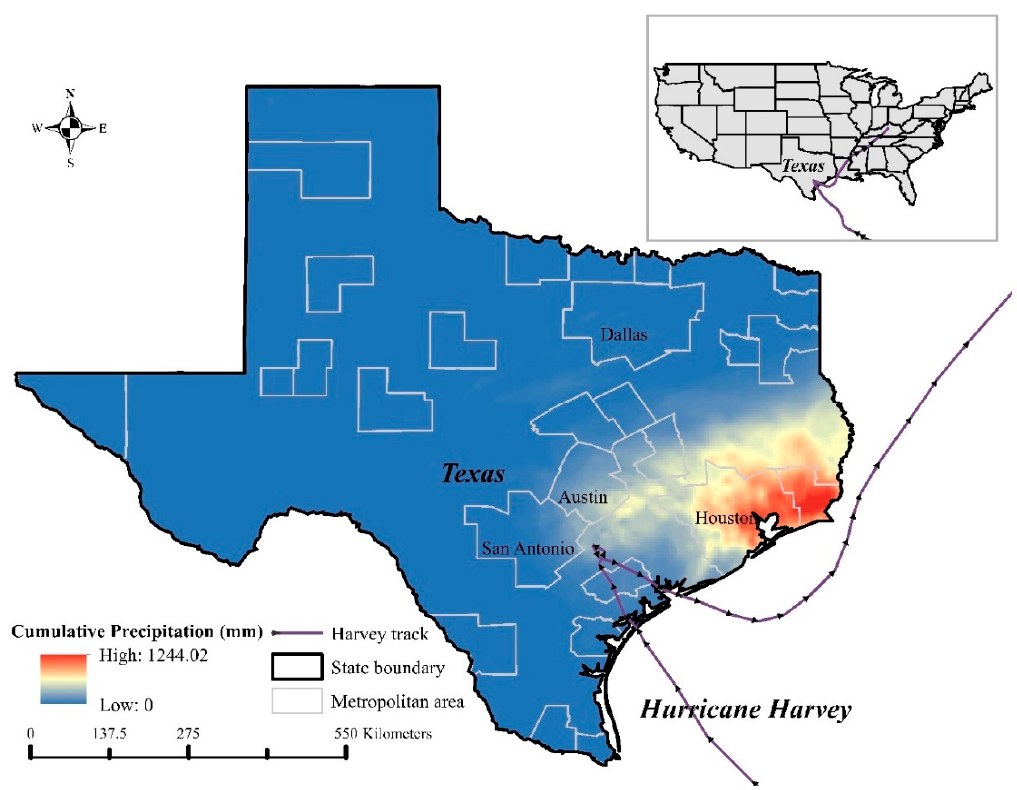
Figure 1. Study area, Hurricane Harvey track, and cumulative precipitation (27–31 August